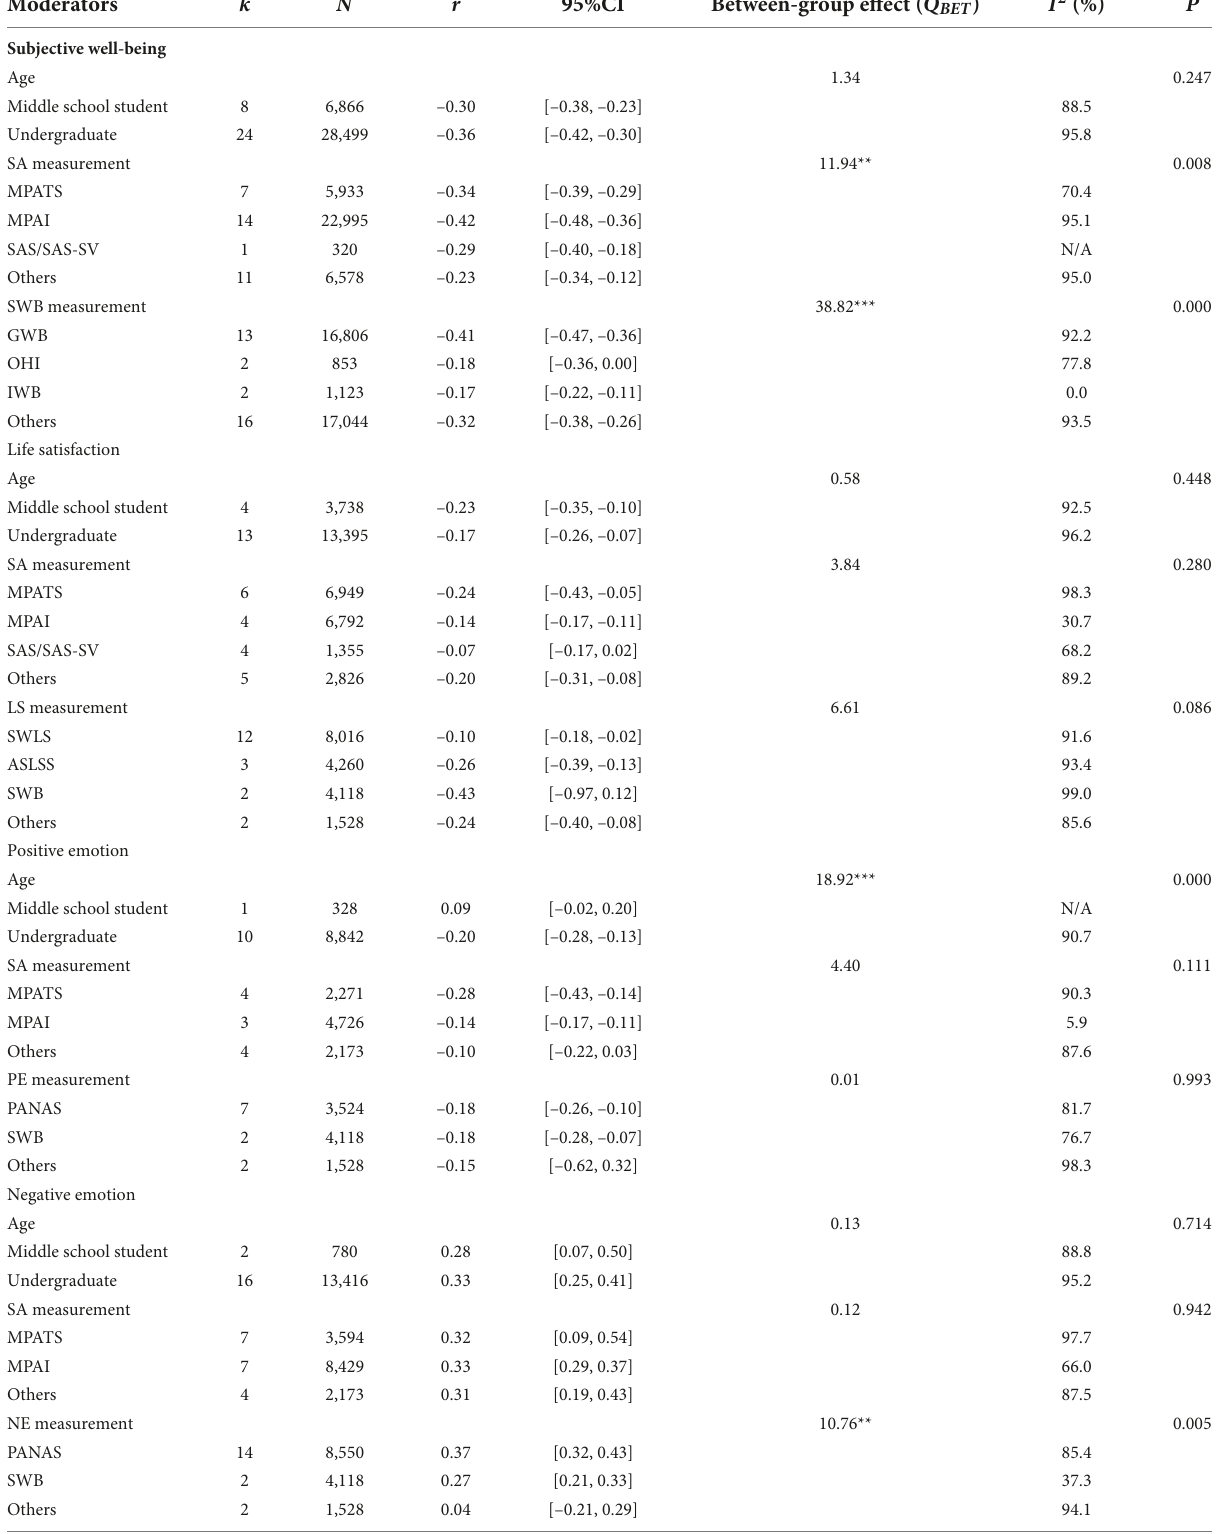
TABLE 6 Subgroup analyses of the summary correlation between SA and subjective